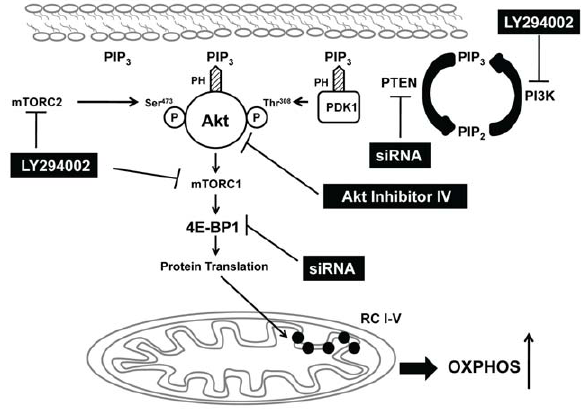
Figure 7. A proposed model of crosstalk between Akt/mTOR/ 4E-BP1 signaling pathway and mitochondria. PTEN knockout in mouse embryonic fibroblasts (MEF PTEN 2 / 2 ) results in an accumulation of PIP 3 produced by PI3K at the plasma membrane. The recruitment of Akt and phosphoinositide-dependent protein kinase 1 (PDK1) by PIP 3 is mediated via their pleckstrin homology (PH) domains. The phosphor- ylation at Ser 473 by mTORC2 and that at Thr 308 by PDK1 leads to a fully activated Akt [39] which then phosphorylates mTORC1. 4E-BP1, the downstream target of mTORC1, on phosphorylation becomes